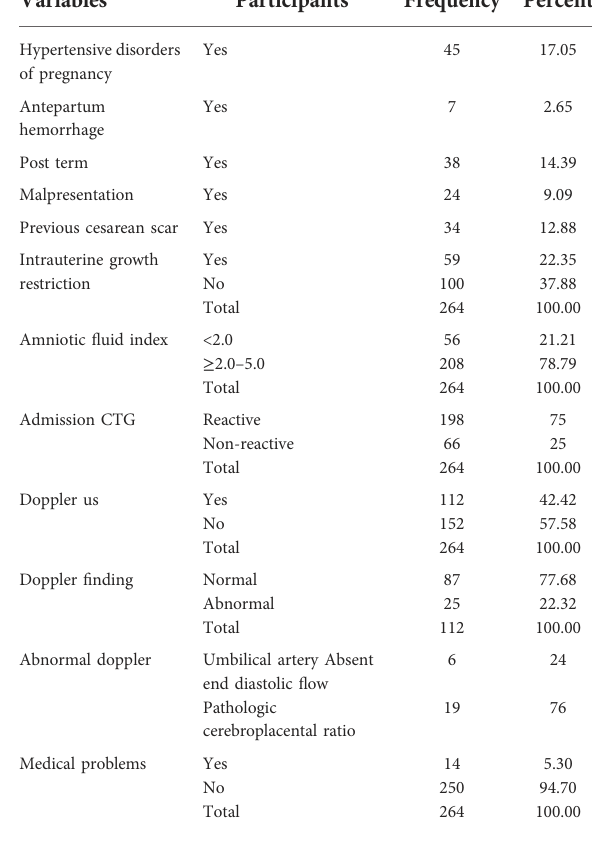
TABLE 3 Antepartum obstetric and medical problems among participants,